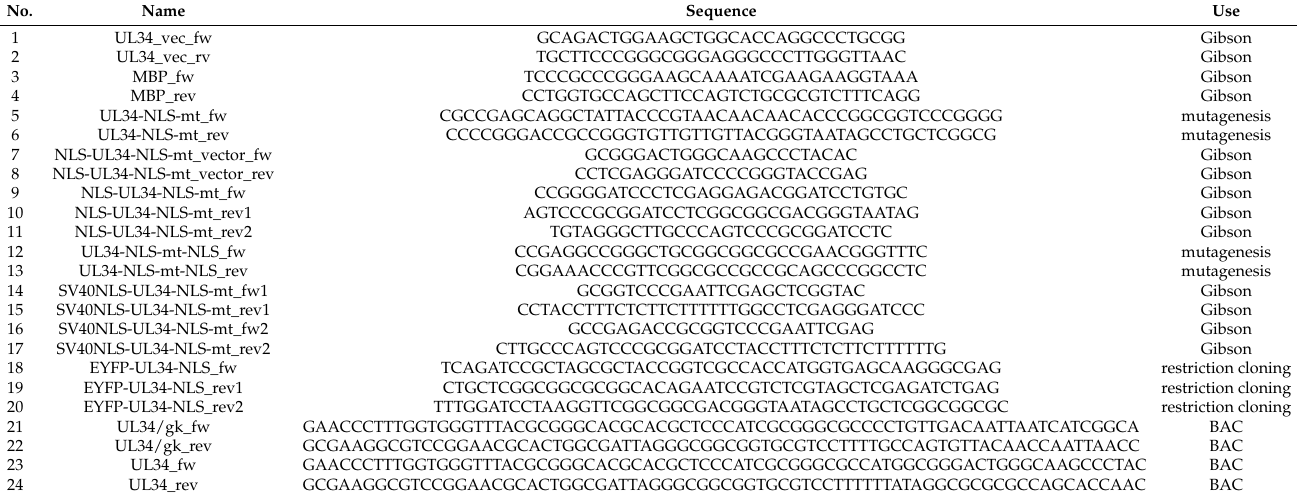
Table 1. Primer sequences used for plasmid cloning, site-directed mutagenesis and BAC